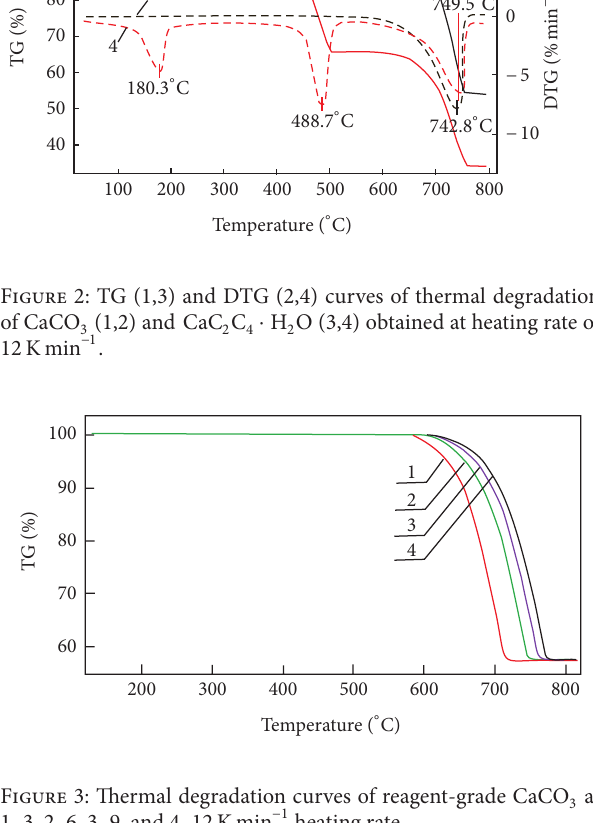
F 3: ermal degradation curves of reagent-grade CaCO